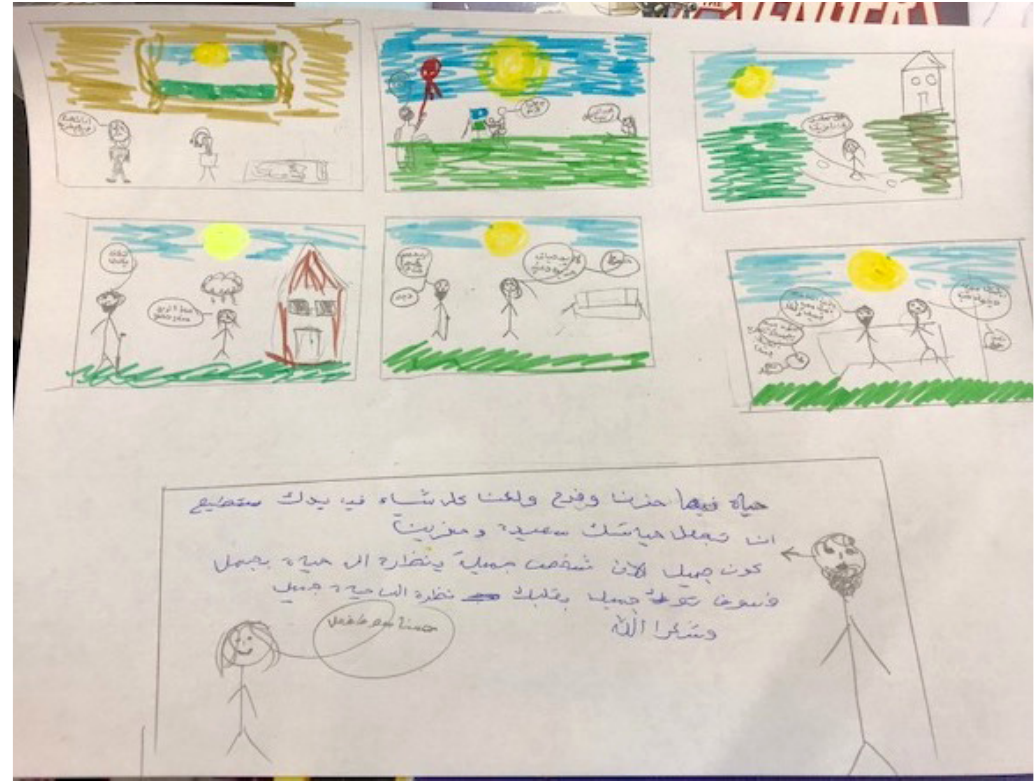
Figure 3. A comic story created during the Athens Comics Library’s